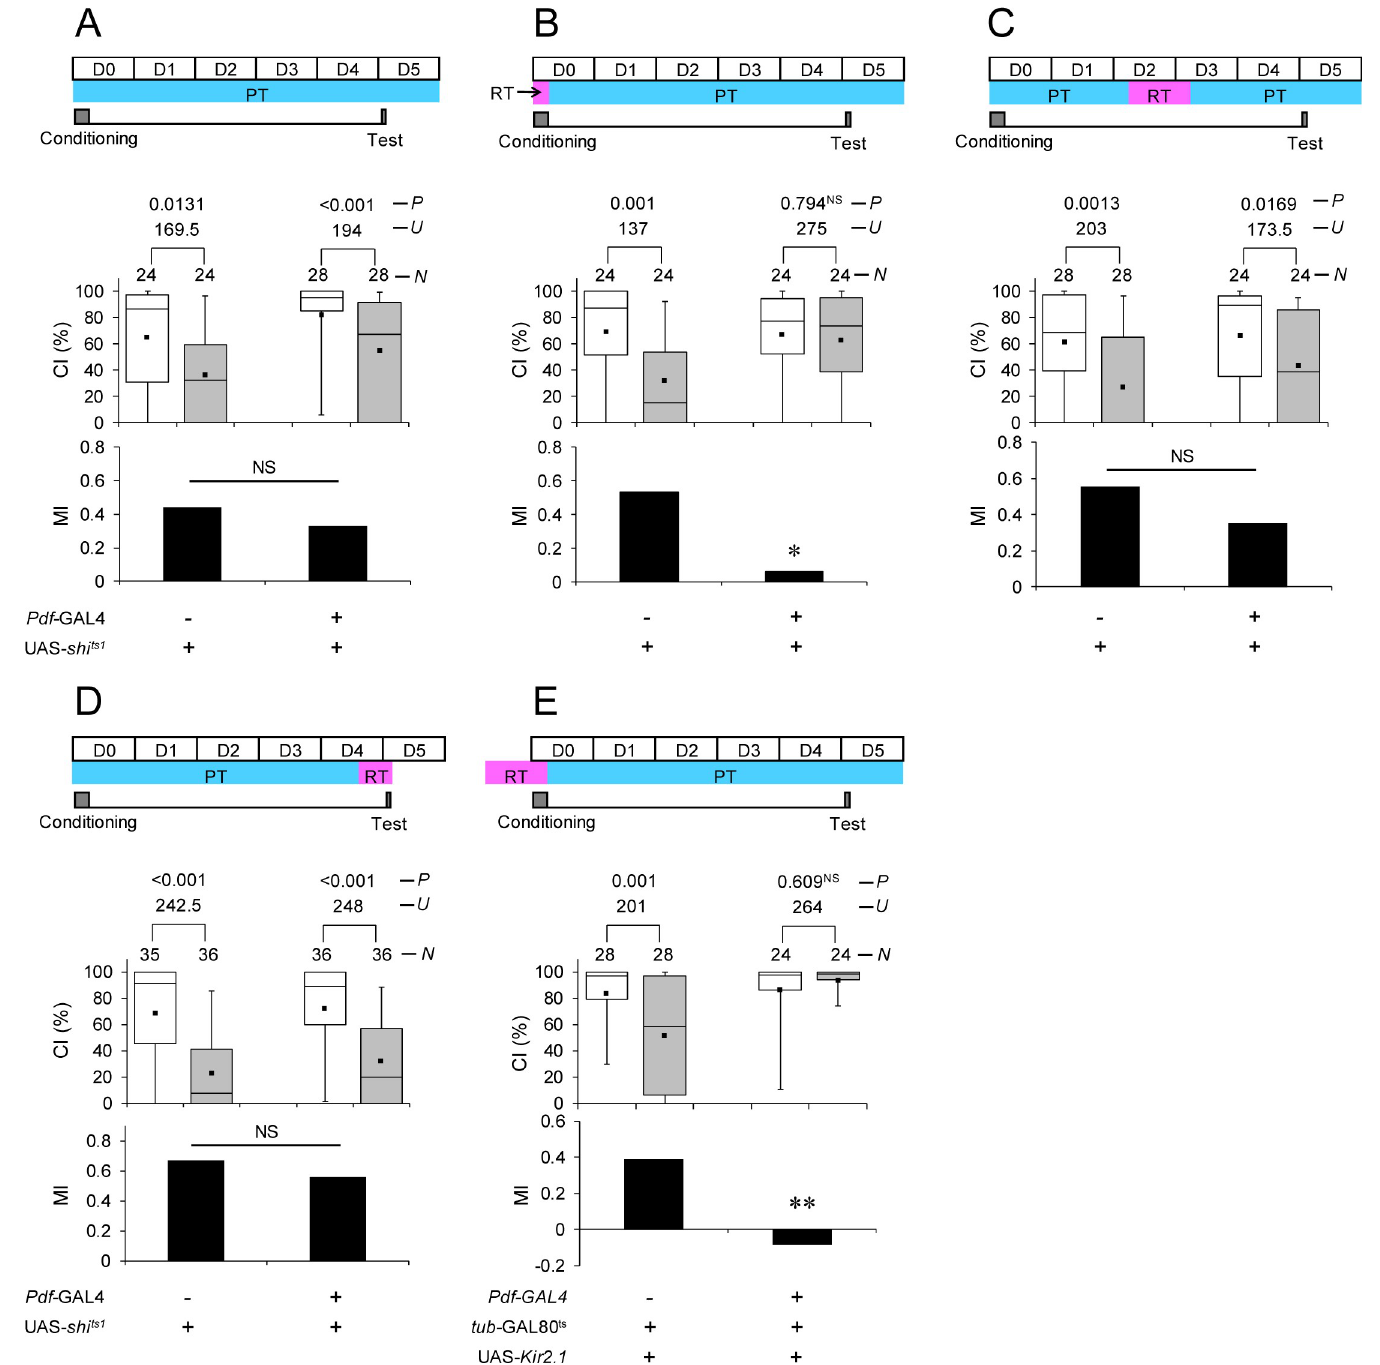
Fig 8. The disruption of the neurotransmission and electrical silencing of Pdf neurons impairs memory consolidation. (A–D) Five-day memory after 7-hour conditioning. Pdf -GAL4/+ (control) and Pdf -GAL4/UAS- shi ts1 flies were used. � , P < 0.05; �� , P < 0.01; NS, not significant. (A) All experiments were performed at PT (25˚C). (B) Flies were kept at RT during conditioning. (C) Flies were kept at RT for 48 to 72 hours after 7-hour conditioning. (D) Flies were kept at RT for 12 hours before the test. (E) Five-day memory after 7-hour conditioning. Flies were kept at RT for 24 hours before the end of conditioning. UAS- Kir2 . 1 / Pdf -GAL4; tub -GAL80 ts / + flies were used. UAS- Kir2 . 1 / tub -GAL80 ts flies were used as the control. (A–E) Box plots for a set of CI data show fifth, 25th, 75th, and 95th centiles. In the box plots, the black square in each box indicates the mean, the line in each box is drawn at the median, the white boxes indicate naive males, and the gray boxes indicate conditioned males. The underlying data can be found in S1 Data. CI, courtship index; MI, memory index; N , sample size; U , Mann–Whitney U ; P , probability. Pdf, pigment dispersing factor; PT, permissive temperature; RT, restrictive temperature.